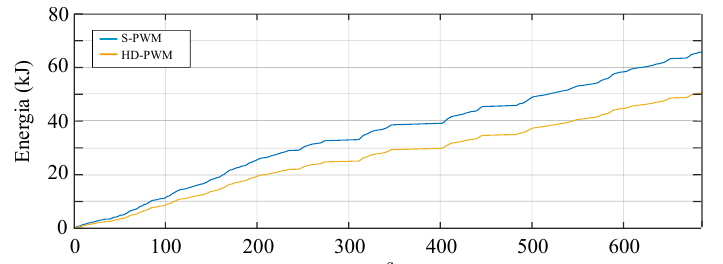
Figure 9. Accumulated energy due to switching losses during urban cycle.